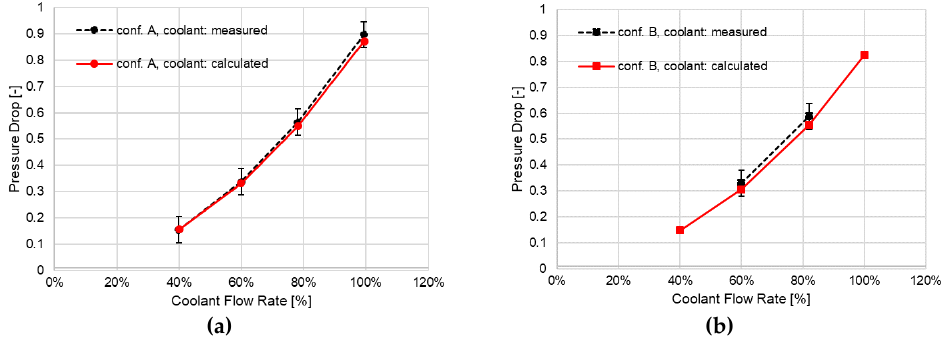
Figure 21. Pressure drop on coolant side: ( a ) Cooler A, with offset-strip fins turbulator and ( b ) cooler B, with dimple-type turbulator. Results are normalized with respect to the maximum value of the dataset (cooler B, oil side, Q oil = 100%).